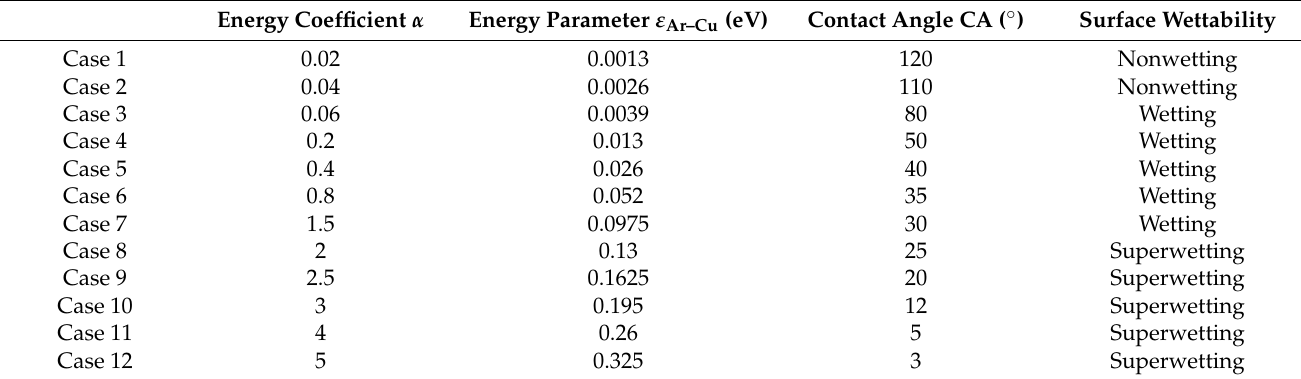
Table 2. Surface wettability under different solid–liquid interactions.